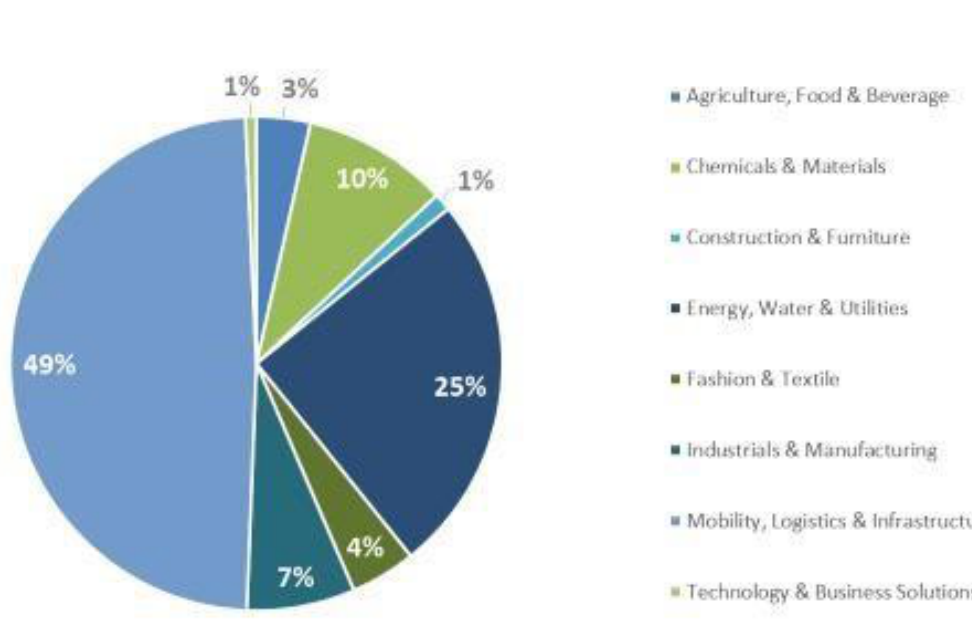
Figure 1: Breakdown of Loans by